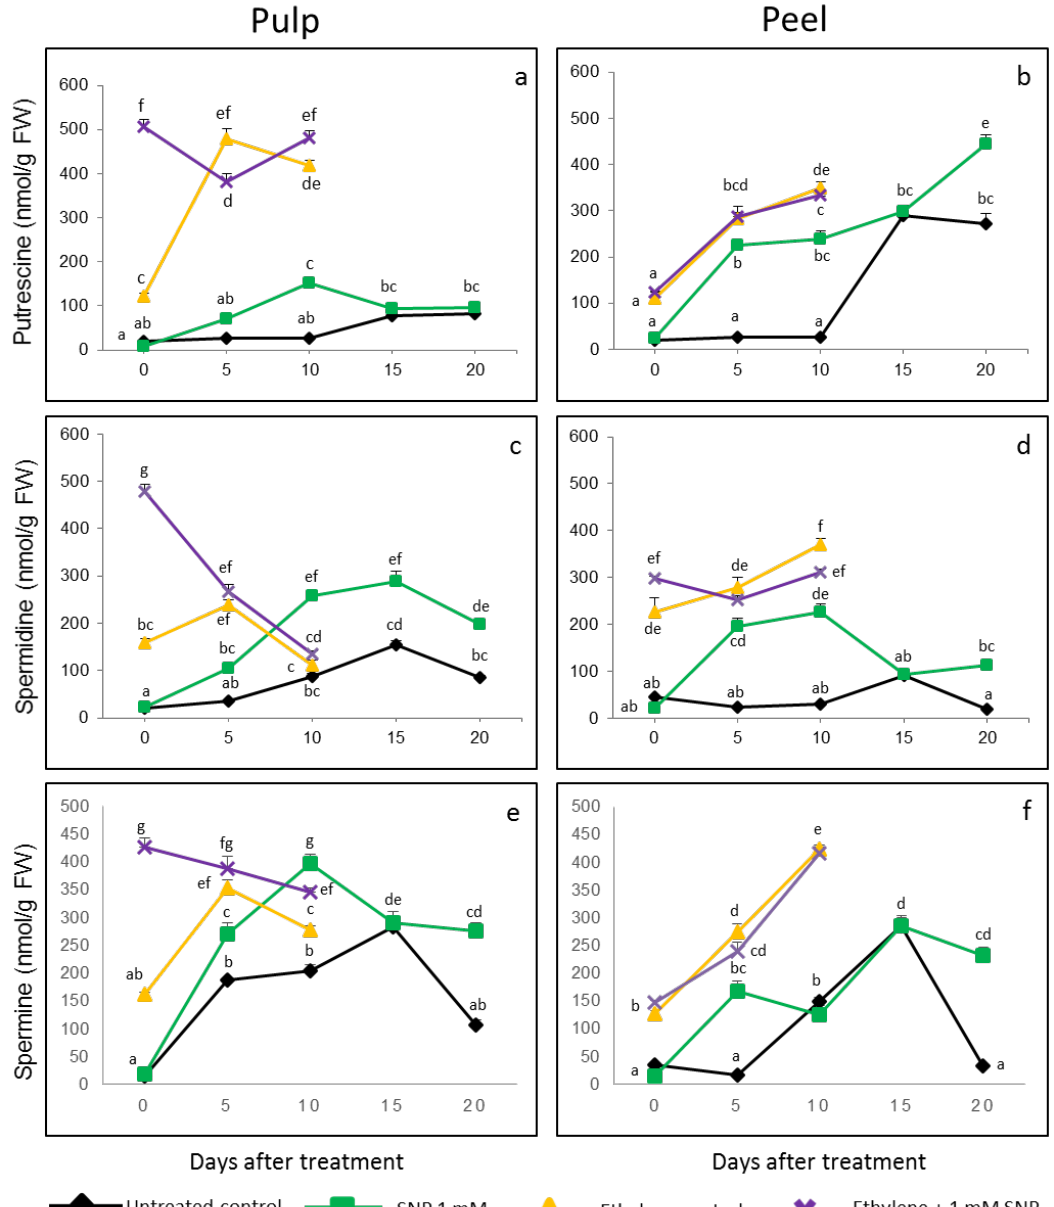
Figure 5. Effect of sodium nitroprusside treatment on polyamine levels in untreated and